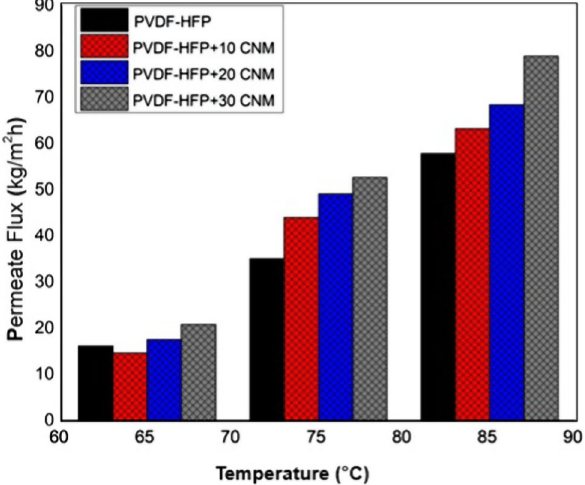
Fig. 8 Effect of the feed temperature on the water